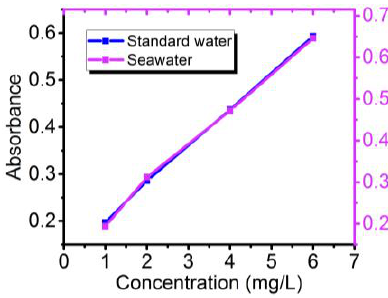
Figure 8. The results of phosphorus determination in standard water and seawater.